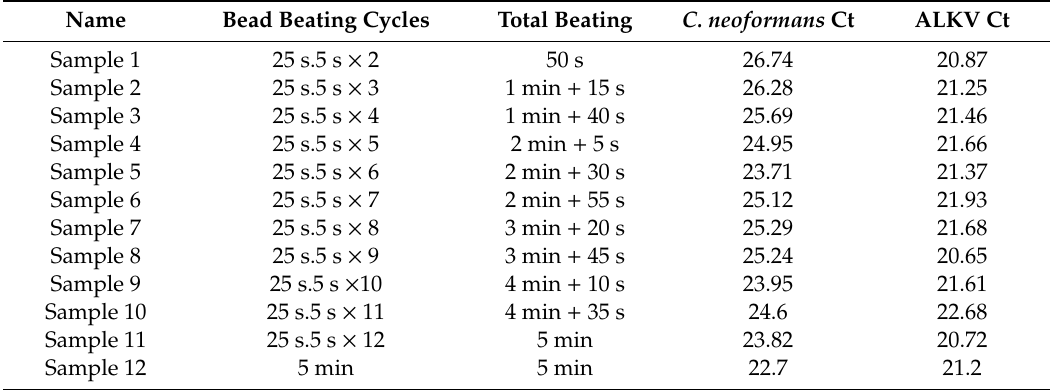
Table A2. The results of the real-time PCR cycle threshold (Ct) for di ff erent cycles of bead